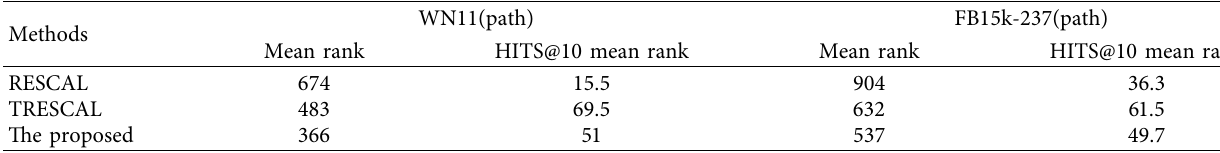
Table 2: Experimental results on paths question answering.